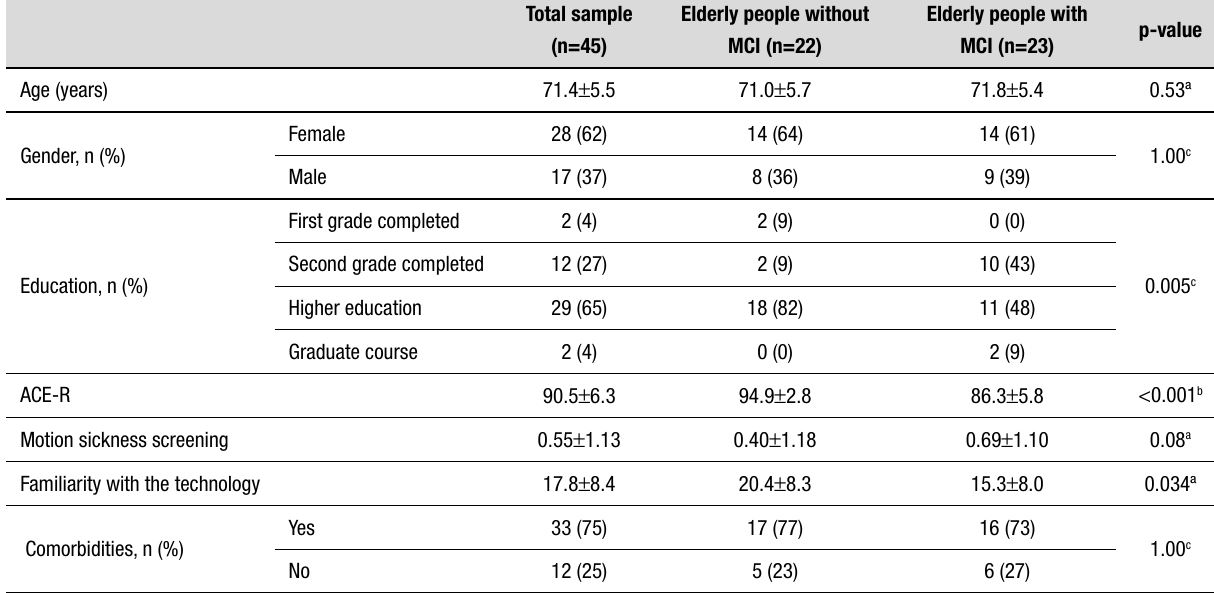
Table 1. Characterization of the total elderly sample and comparison between older adults with and without mild cognitive impairment.